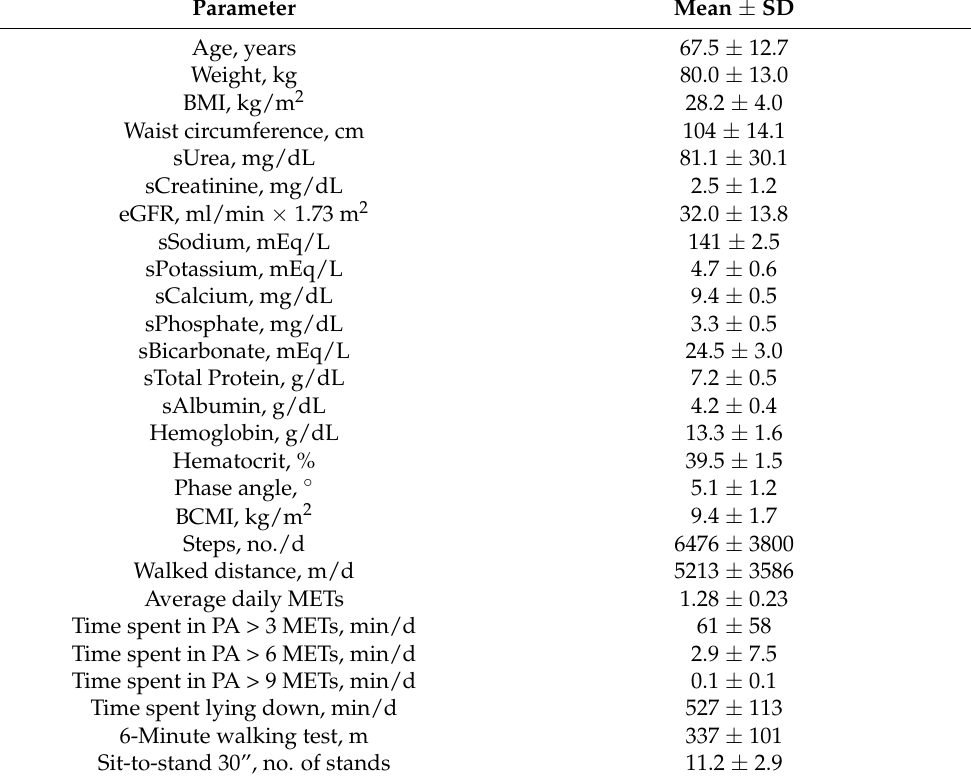
Table 1. Clinical features, anthropometry and physical function of the studied